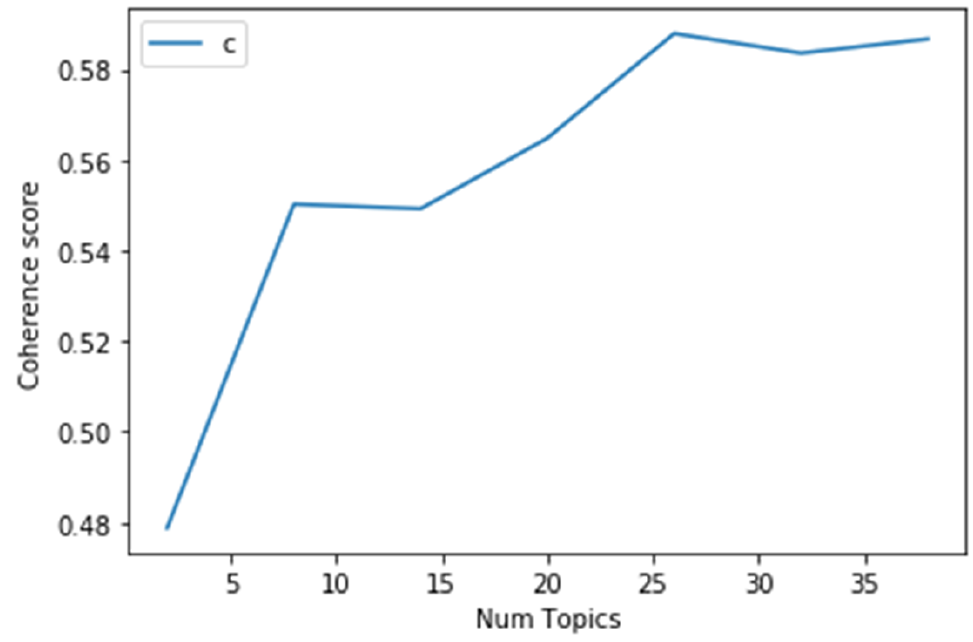
Figure 3. Coherence score for different topic number. Figure 3. coherence score for different topic number. Table 1. Topic classification and key